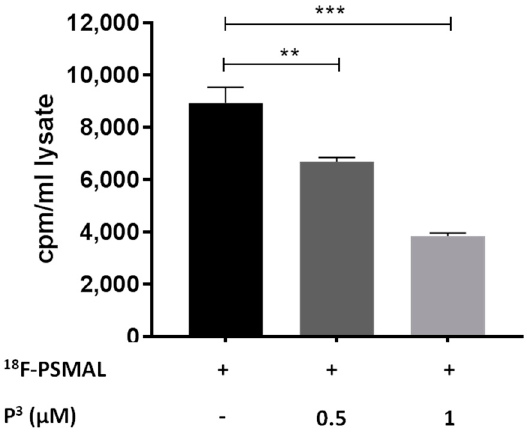
Figure 5. Uptake of 18 F-PSMAL by LNCaP cells in presence of P 3 (** p = 0.0088, *** p = 0.0001).